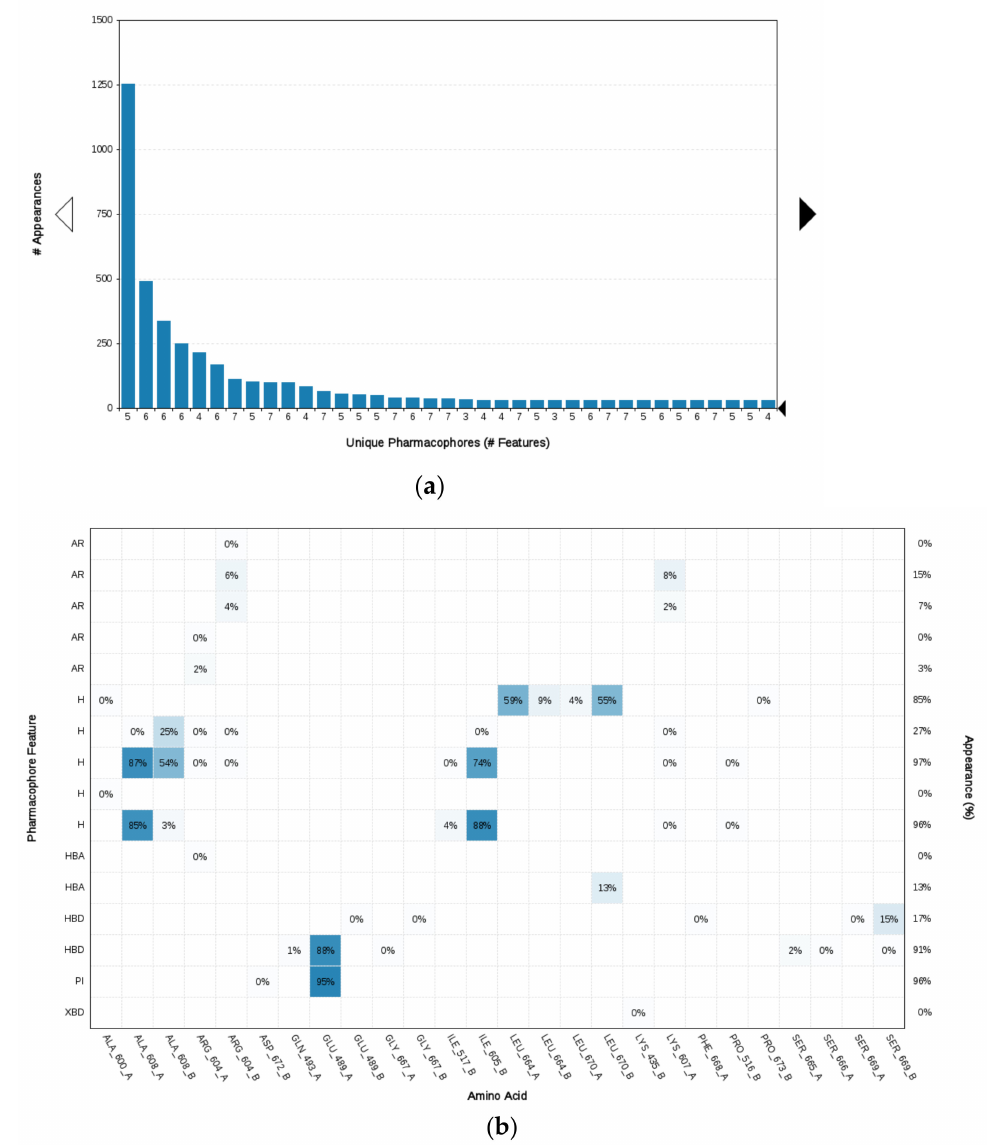
Figure 8. ( a ) Plot of the most frequent unique structure-based pharmacophore models derived from the molecular dynamics simulations of the Hsp90 C-terminal domain in complex with 7l . The numbers below the bars indicate the numbers of interaction features observed during molec- ular dynamics simulation for the pharmacophore models. ( b ) MD Interaction map obtained by analysing interactions of 7l with Hsp90 CTD binding site residues in the 1 µ s MD simulation trajectory. Amino acid name and numbering is shown on x -axis, pharmacophore feature type on the left y -axis (H—hydrophobic, HBA—hydrogen bond acceptor, HBD—hydrogen bond donor, PI—positive ioniz- able, AR—aromatic), % appearance on the right y